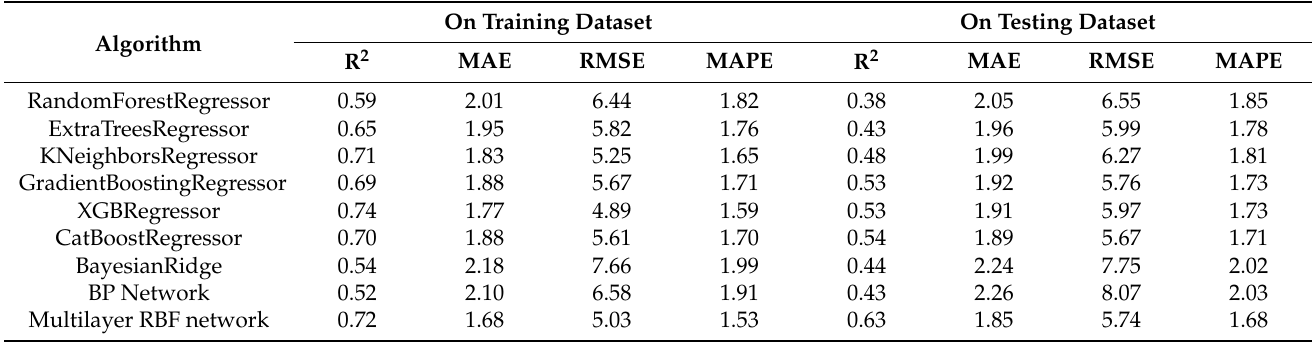
Table 2. Performance comparison of all models in R 2 , RMSE, MAE, and MAPE.